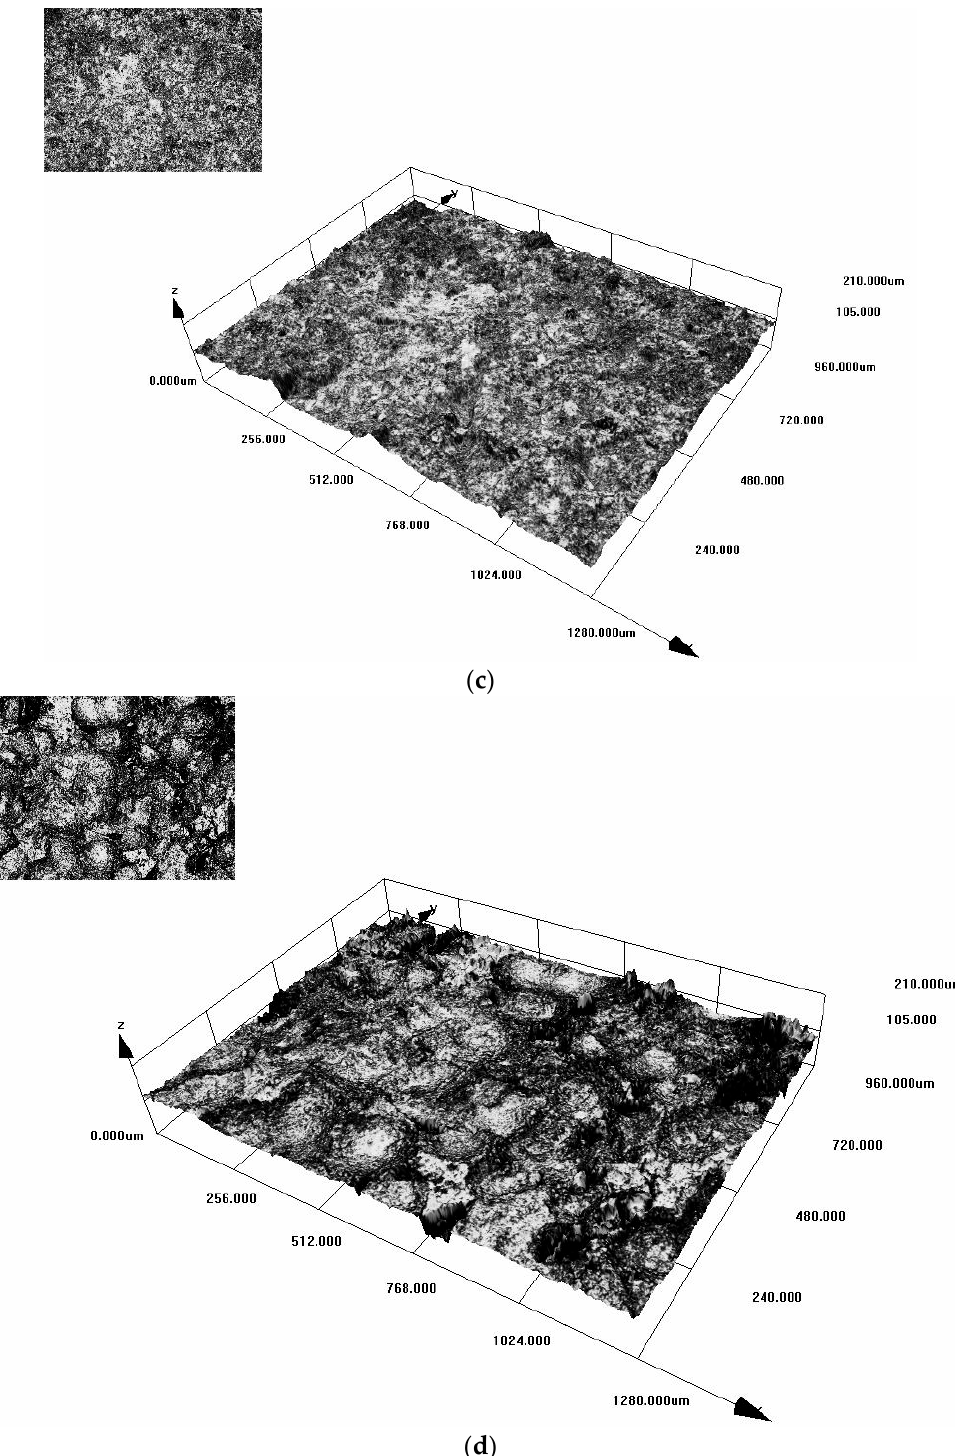
Figure 7. Microscopic snapshot of the surface and 3D appearance—blasting surface ( a ) SG, ( b ) C, ( c ) DSS, ( d ) SS.